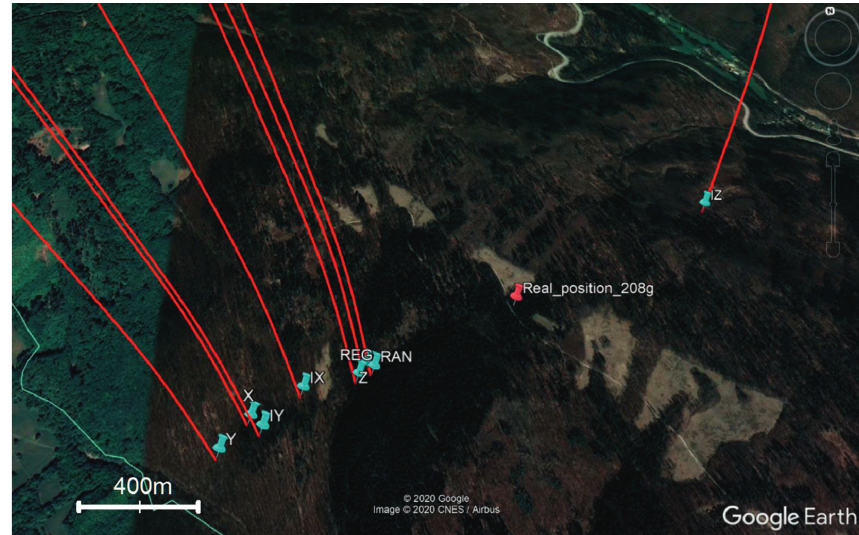
Figure 9: Detail on the shape of the impact area for the individual modeled orientations. On the right, we can see a significant shift of the impact place for orientation IZ , compared to other orientations. Real position of the meteorite is equivalent to spherical model